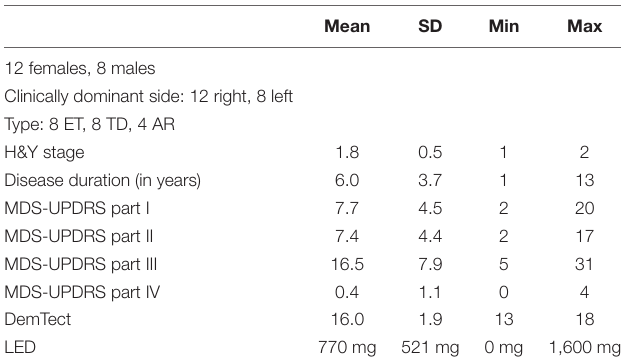
TABLE 1 | Patient